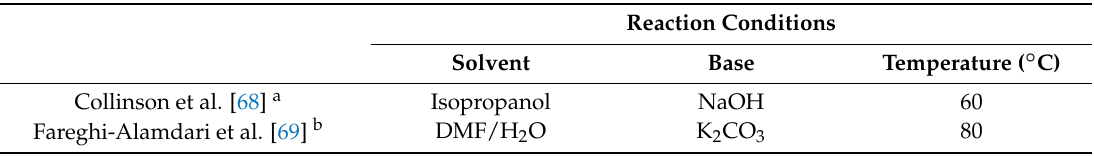
Table 4. The reaction conditions for Suzuki cross-coupling reactions catalysed by supported palladium complexes in references [68,69].